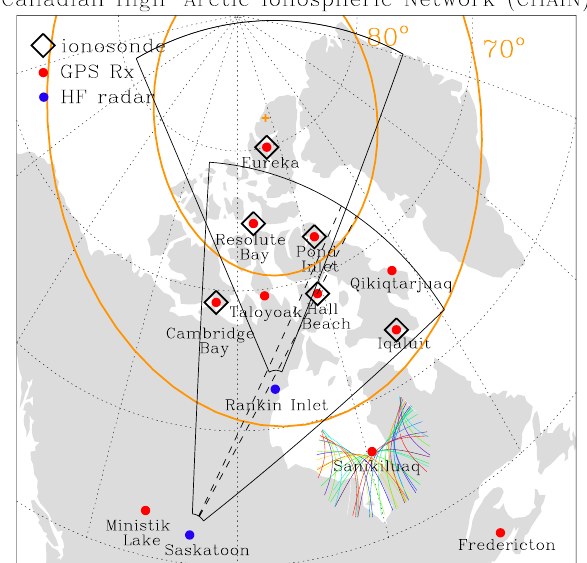
Fig. 1. Canadian High Arctic Ionospheric Network (CHAIN). The loci of ionospheric pierce points (IPPs) at 350 km altitude for all GPS satellites as seen from Sanikiluaq at elevation angles above 30 ◦ during one day are shown. The corrected geomagnetic (CGM) latitudes 70 ◦ and 80 ◦ and fields of view of two SuperDARN radars are superposed over the geographic grid. Beam 8 for the Saskatoon radar that is used in the statistical study is shown with dashed